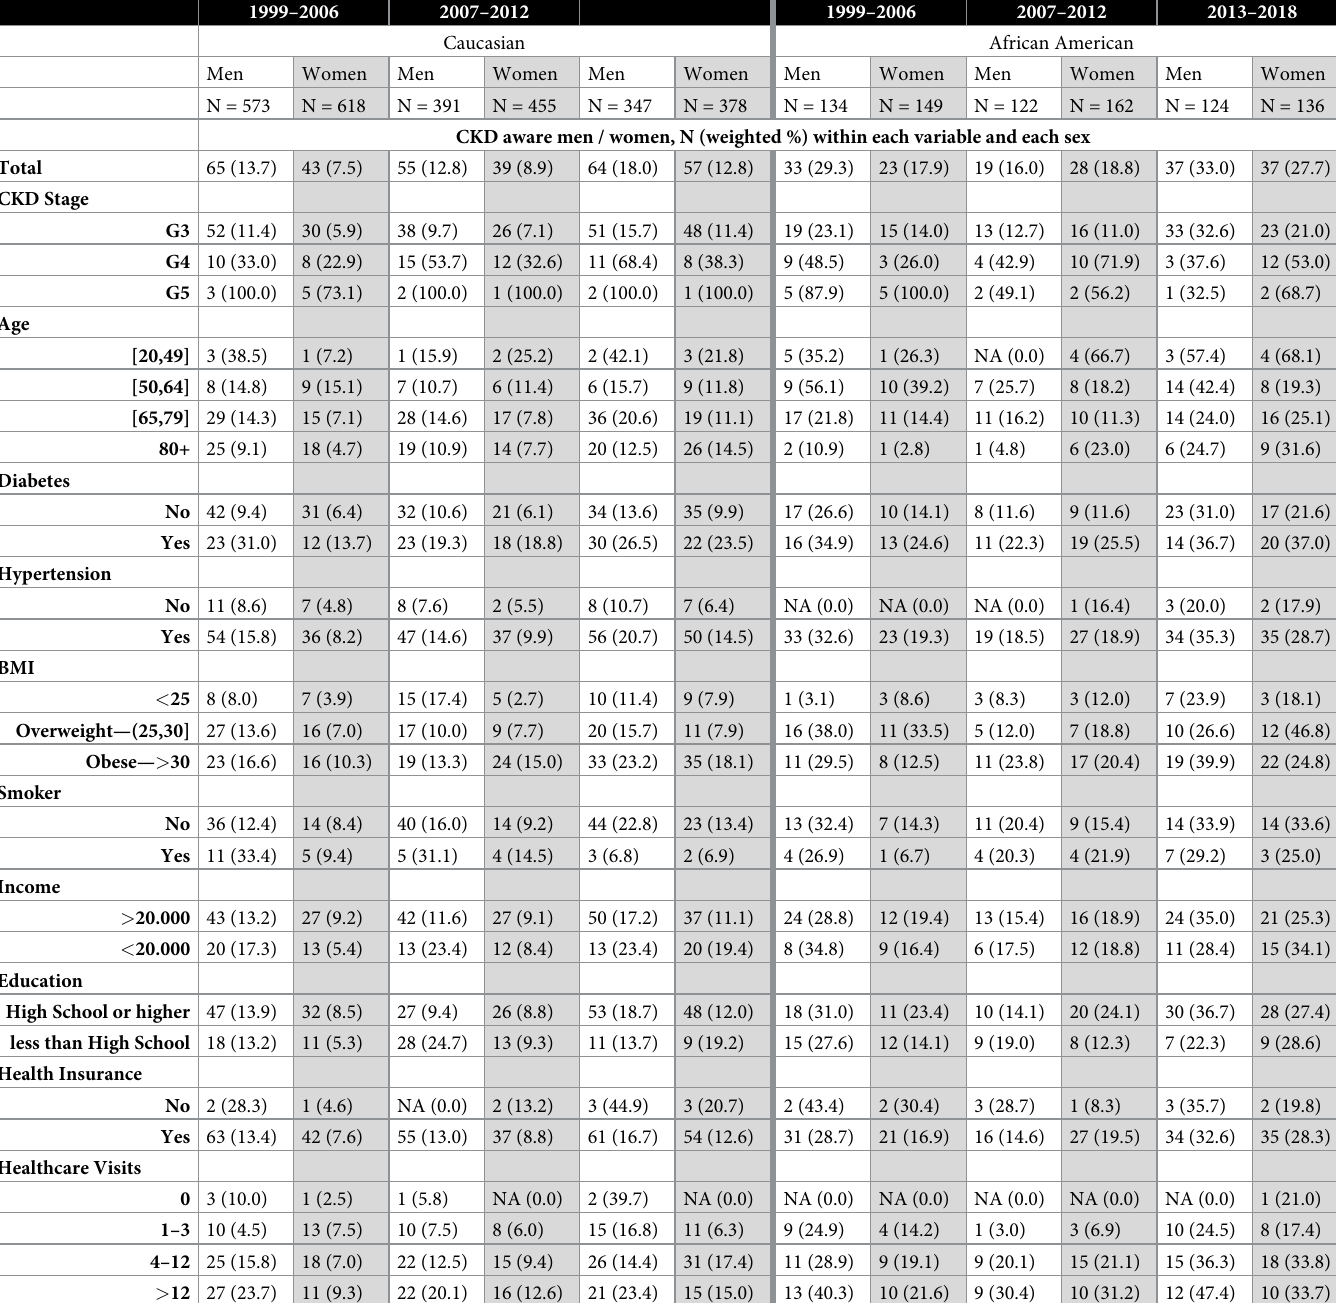
Table 2. Characteristics of CKD aware Caucasians (left) and African Americans (right), by 8- or 6-year study period and